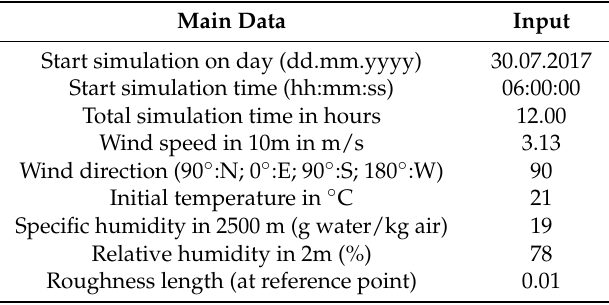
Table 3. Initial parameters of all